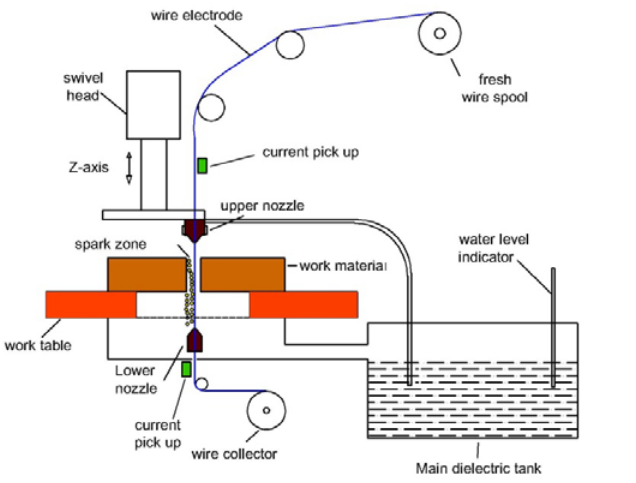
Fig. 1. Schematic representation of WEDM